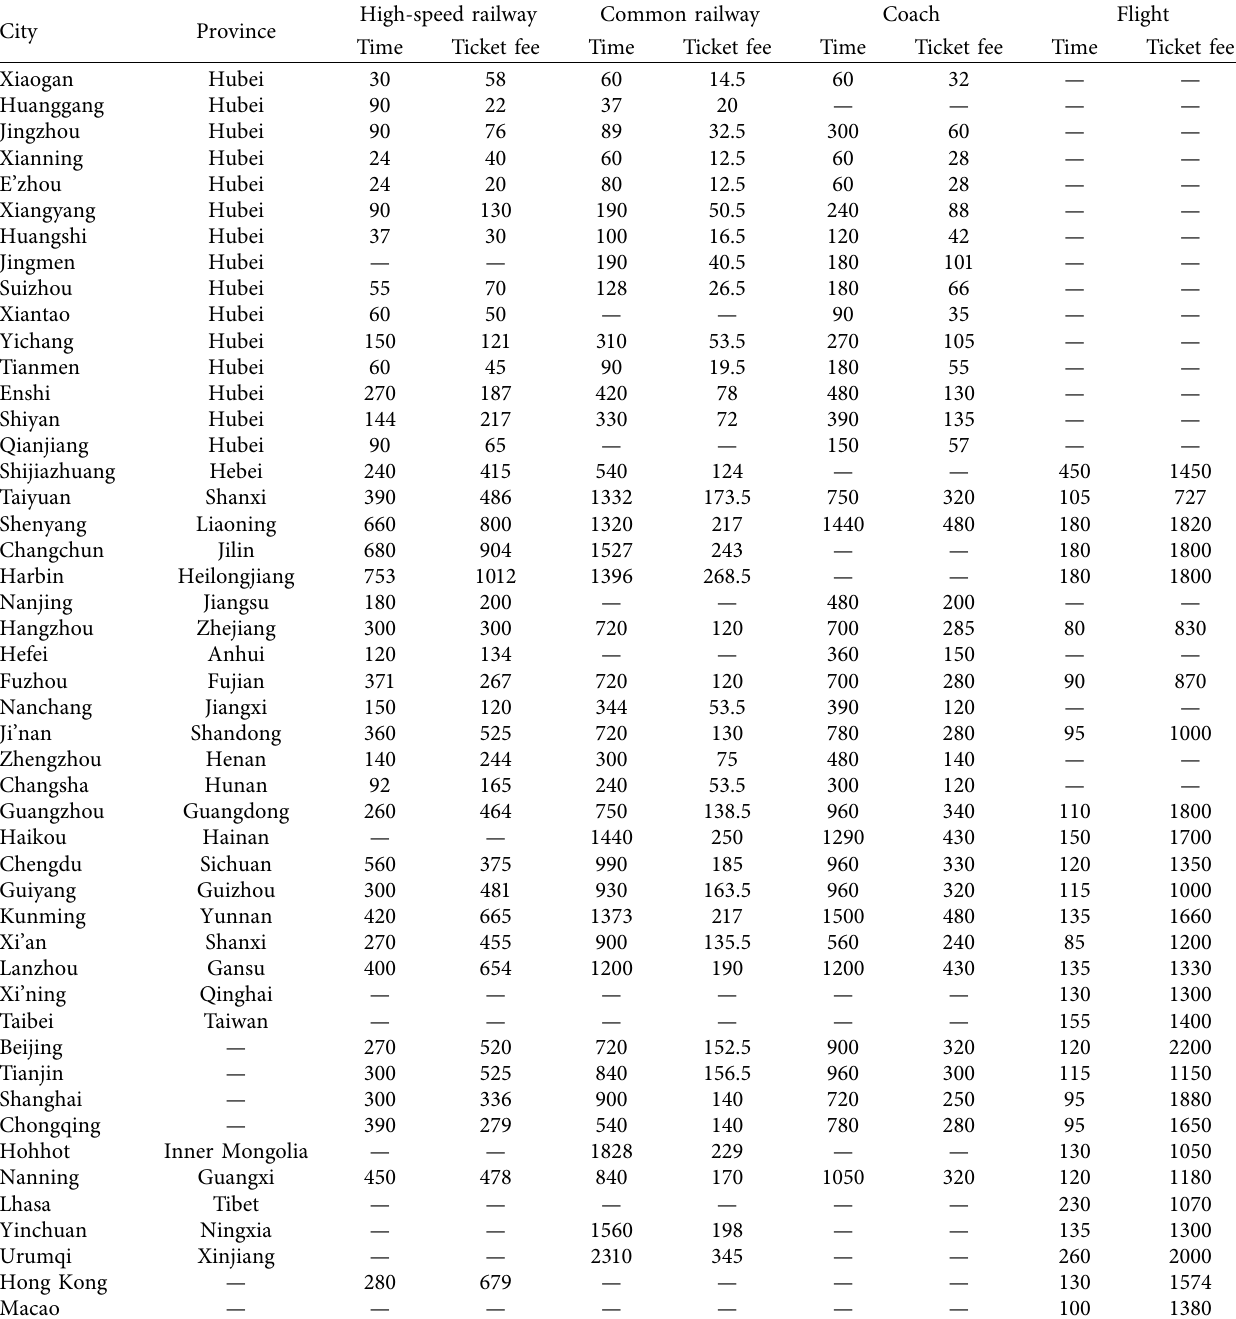
Table 2: Transportation parameters of high-speed railway, common railway, coach, and